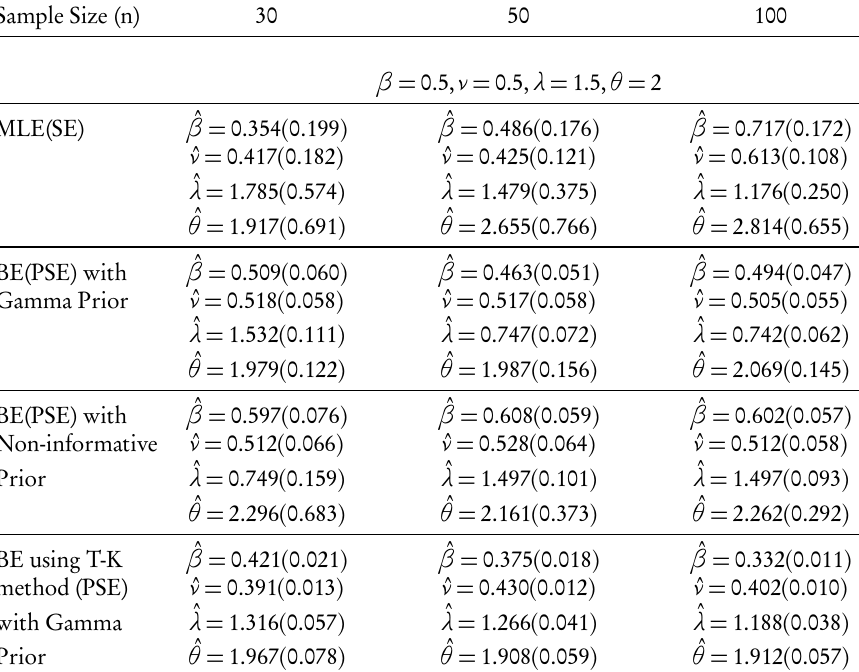
Various estimates along with their estimated